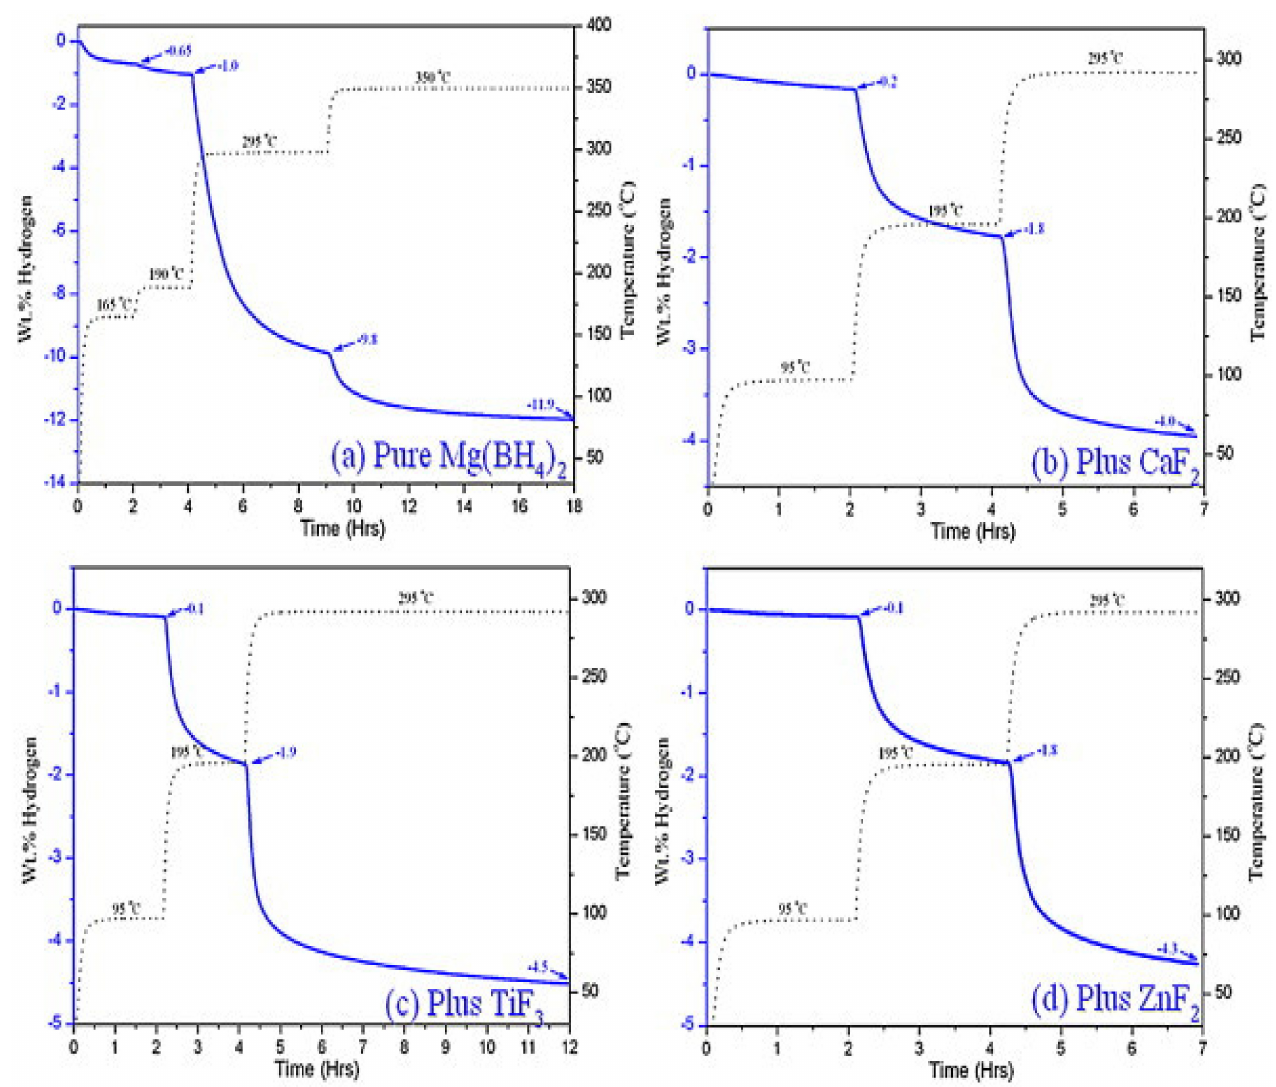
Figure 8. Hydrogen desorption profiles for ( a ) pristine Mg(BH 4 ) 2 and fluoride-doped Mg(BH 4 ) 2 : ( b ) CaF 2 ; ( c ) TiF 3 and ( d ) ZnF 2